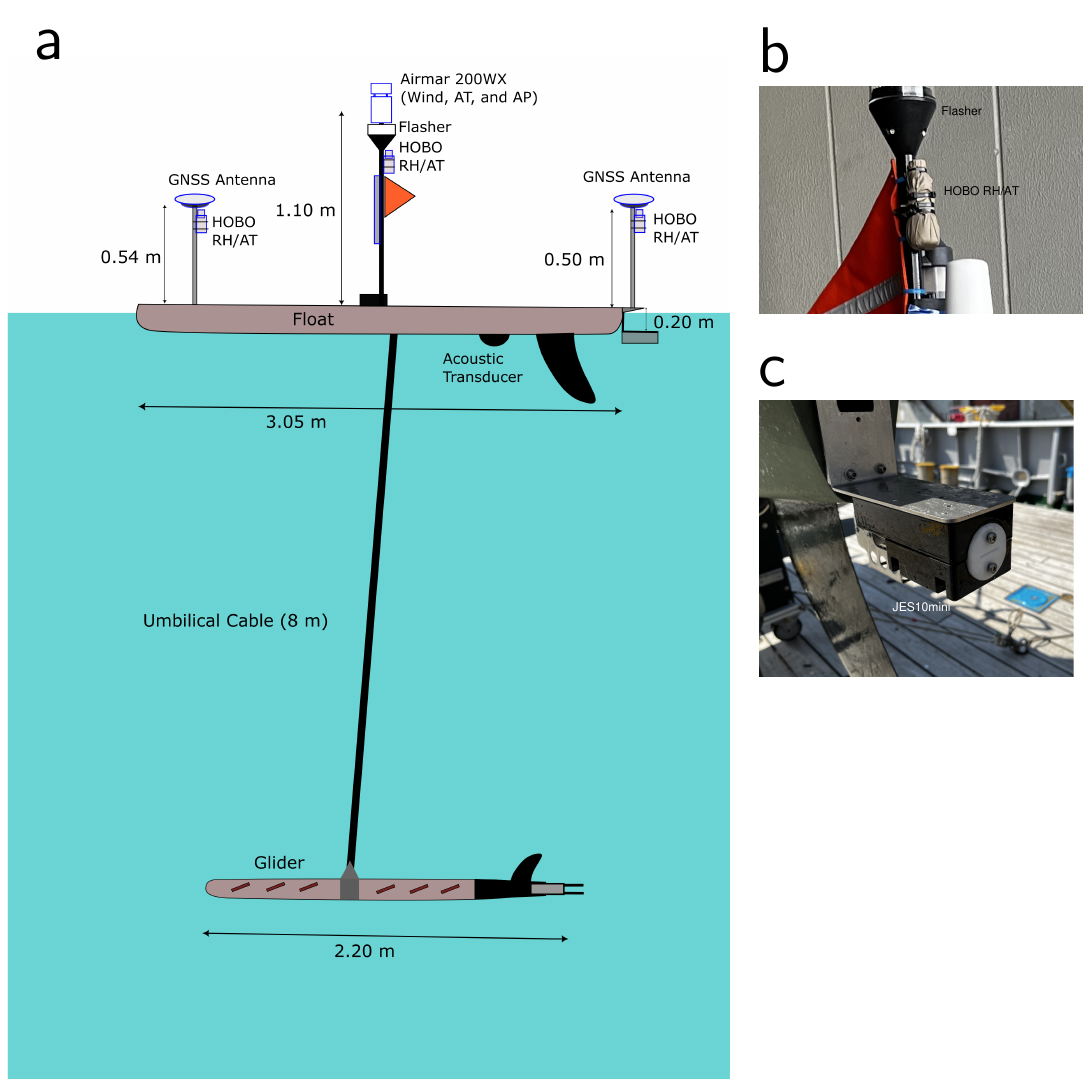
Figure 2. ( a ) Diagram of a Wave Glider SV3. Images of ( b ) the HOBO data logger on the middle mast of the WG and ( c ) the CTD JES10mini under the tail of the WG float. The HOBO sensor in panel ( b ) is covered by beige Gore-Tex